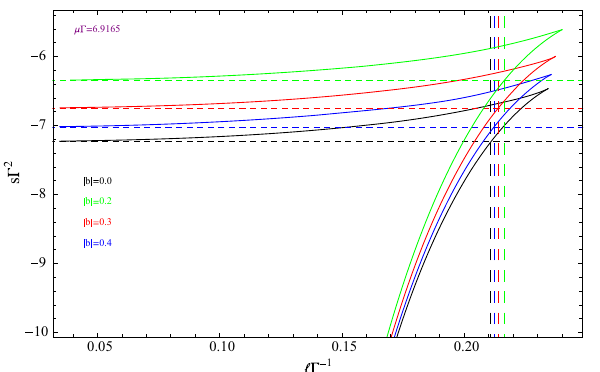
Fig. 4 The entanglement entropy as a function of the stripwidth (cid:16) with different parameter b for μ(cid:10) = 6 . 9165. The black curve is for | b | = 0 and the blue curve is for | b | = 0 . 2. The red curve is for | b | = 0 . 3 and the green curve is for | b | = 0 . 4. The corresponding critical widths are (cid:16) c (cid:10) − 1 = 0 . 2109, (cid:16) c (cid:10) − 1 = 0 . 2122, (cid:16) c (cid:10) − 1 = 0 . 2139, (cid:16) c (cid:10) − 1 = 0 . 2164, respectively